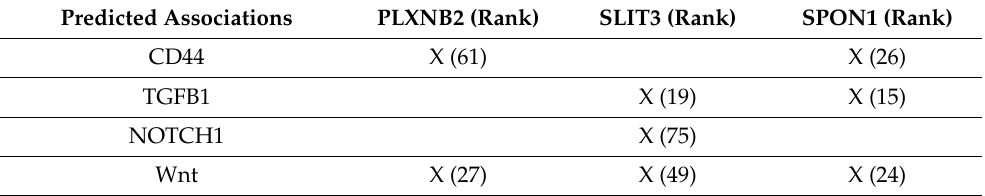
Table 1. Cont. Predicted Associations